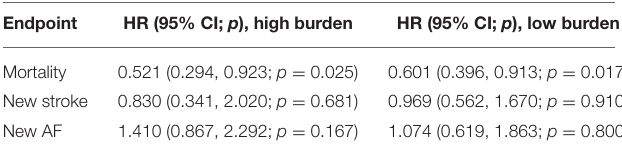
TABLE 3 | Endpoint hazard ratios in high-burden and low-burden PAC sub-cohorts. Endpoint HR (95% CI; p ), high